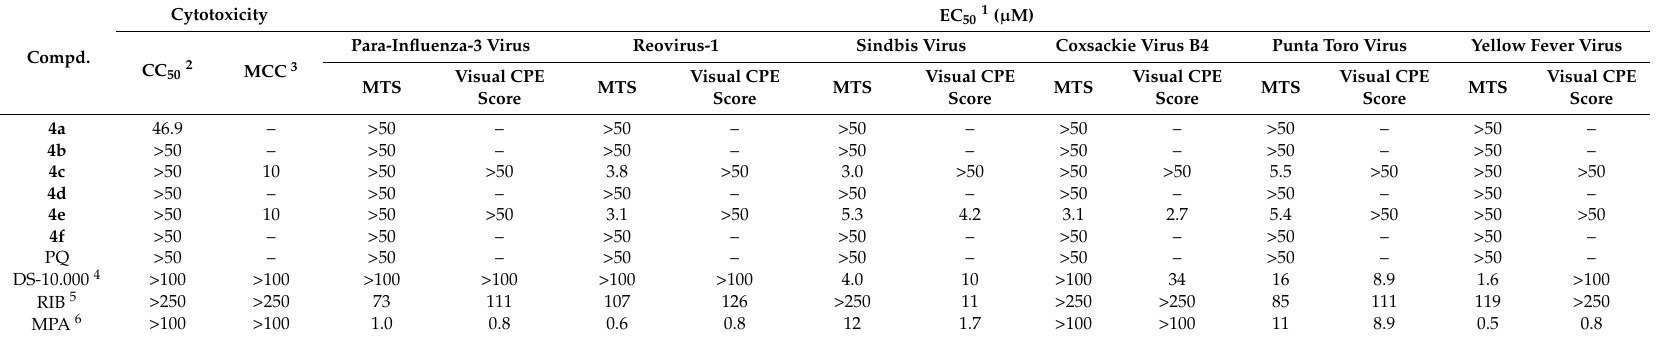
Table 3. Cytotoxicity and antiviral activity of fumardiamides 4a – f evaluated in Vero cell